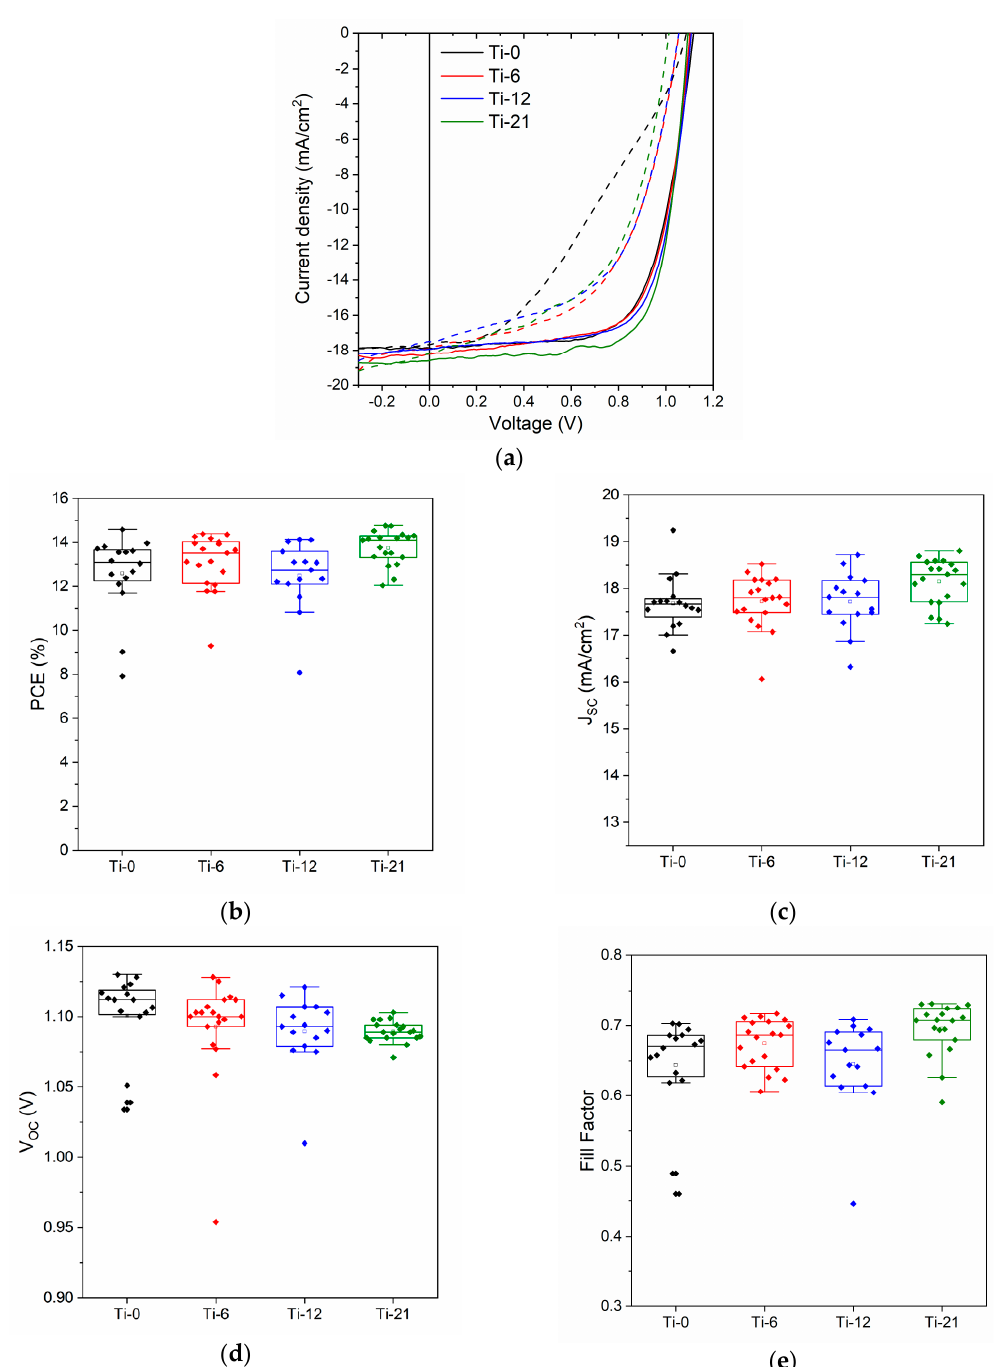
Figure 4. ( a ) Representative J-V curves in forward (dashed lines) and reverse (solid lines) sweep for devices with increasing porosity in the TiO 2 layer. The solar cells were measured at a scan rate of 10 mV/s and AM 1.5 G illumination with light intensity of 100 mW/cm 2 ; Changes in ( b ) device efficiencies, ( c ) J SC , ( d ) V OC , and ( e ) FF for devices measured in reverse sweep with increase in porosity in the TiO 2 layer.